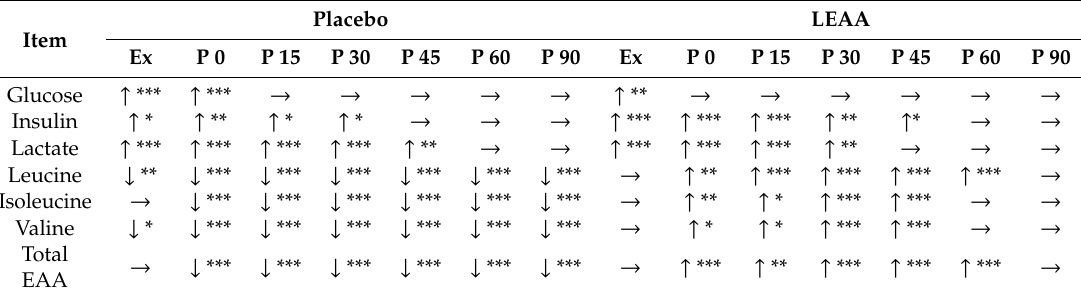
Arrows pointing up and down indicate increases and decreases in the pretreatment values in each group. Horizontal arrows indicate unchanged values from the pretreatment values in each group. Ex and P 0-P 90 indicate sampling timepoints taken after the completion of leg extension and 0-90 min post-exercise, respectively. The data were analyzed using Dunnett’s test. * p < 0.05, ** p < 0.01, *** p < 0.001 vs. pretreatment for each group.